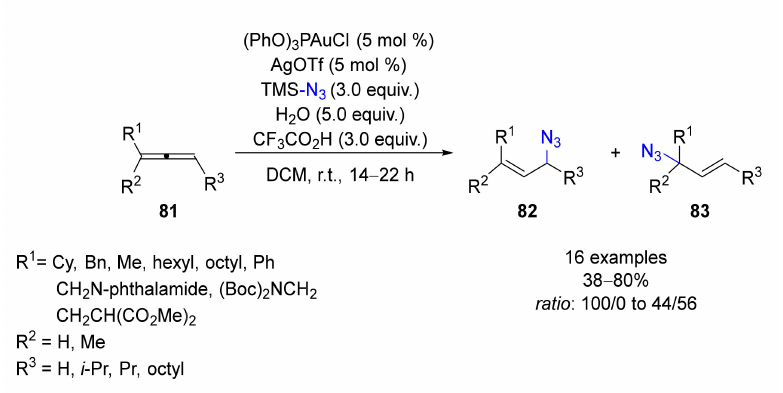
Scheme 78. Gold(I)-catalyzed azidation of